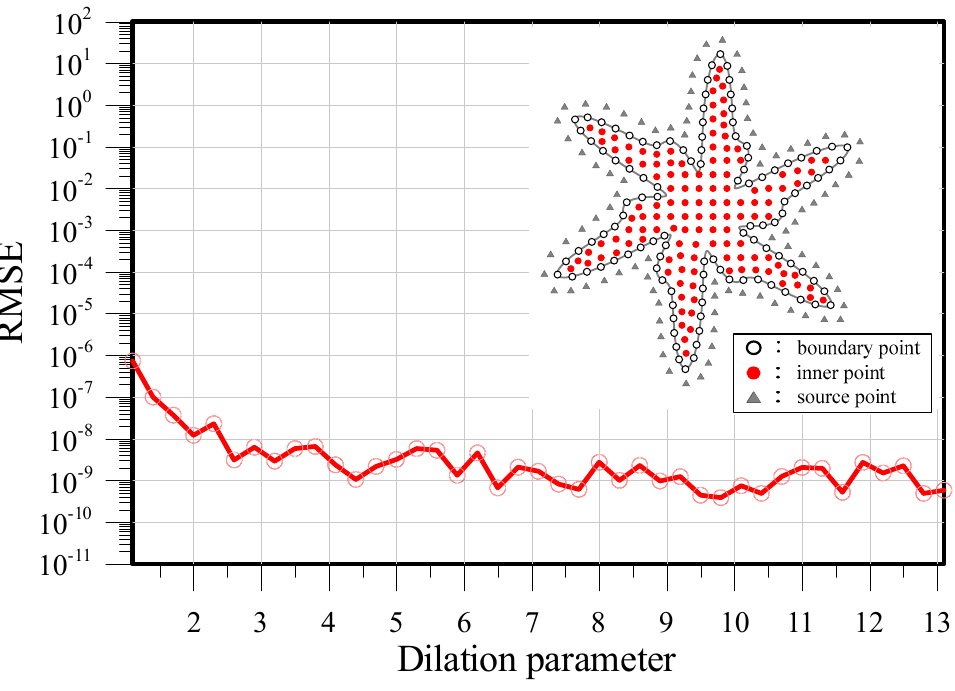
Figure 3. Transient radial polynomial series function ( TRPSF) terms versus RMSE.